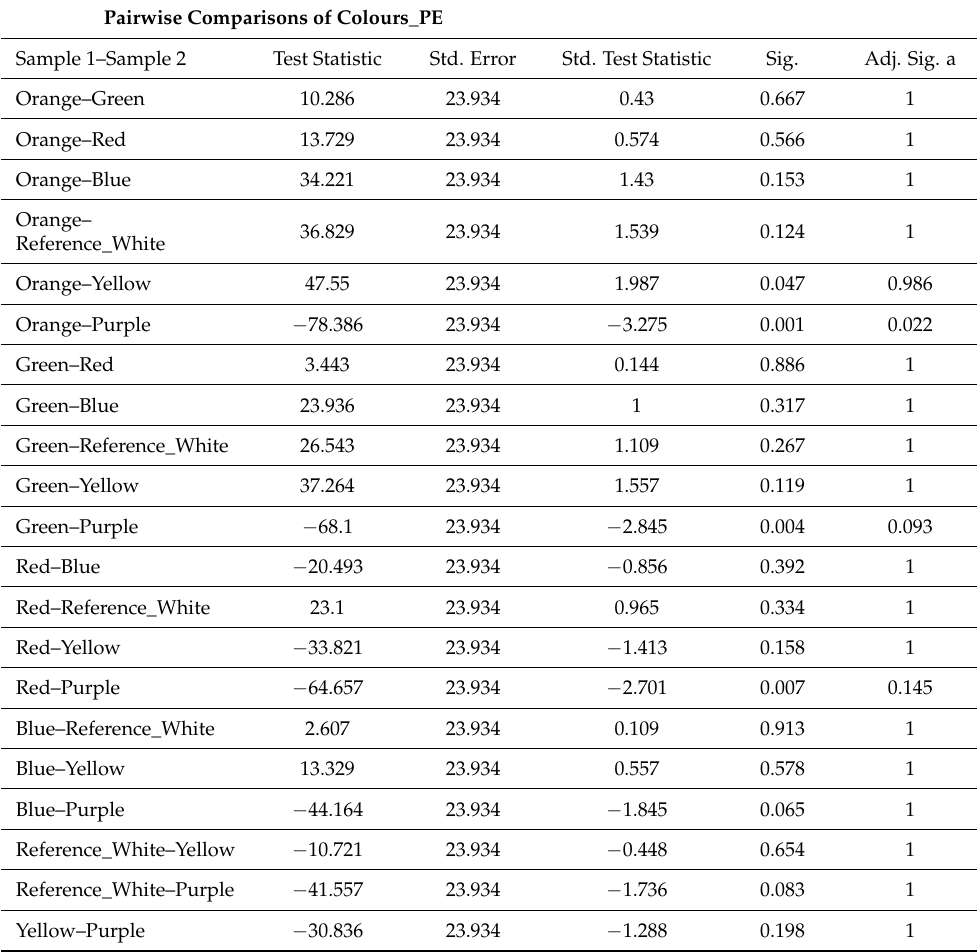
Table A9. Effects on response time (attention to